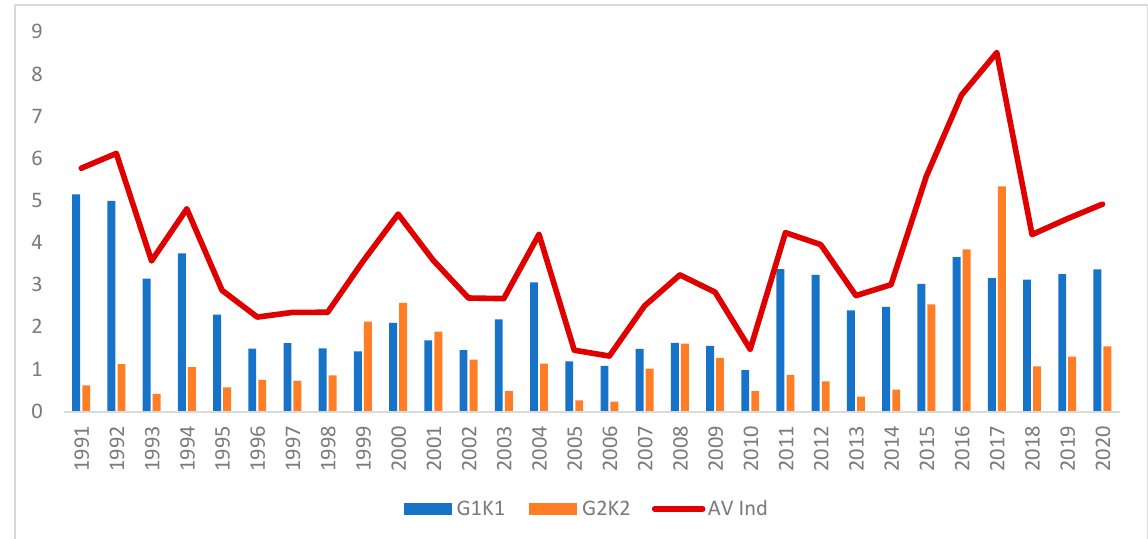
Figure 4. Availability index and sub-indices.